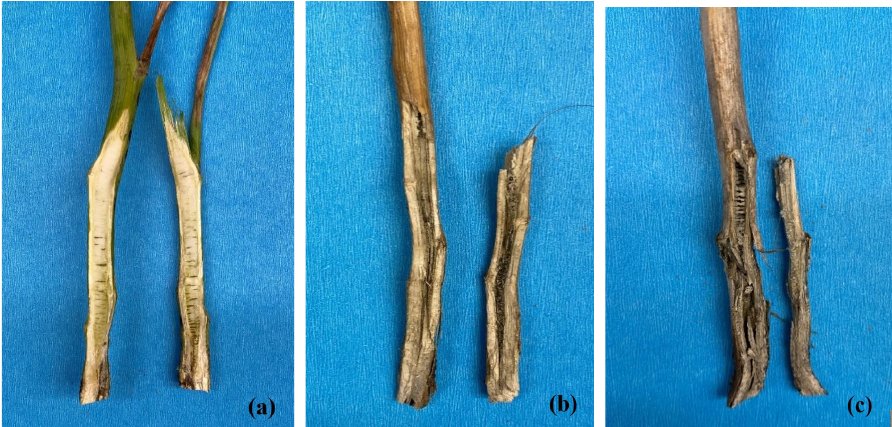
Figure 8. Longitudinal sections of canola stems infected by Leptosphaeria maculans ( a ), Verticillium longisporum ( b ), and both pathogens ( c ).